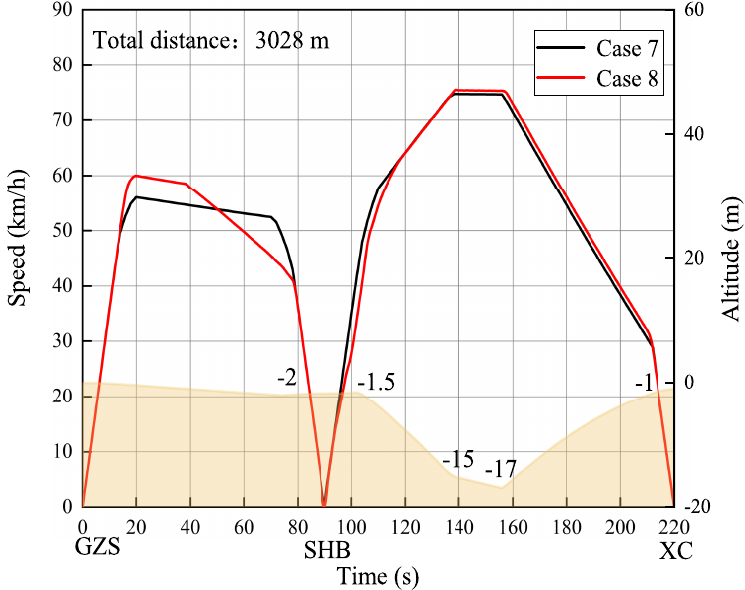
Figure 15. The optimal speed trajectories and altitude profile for cases